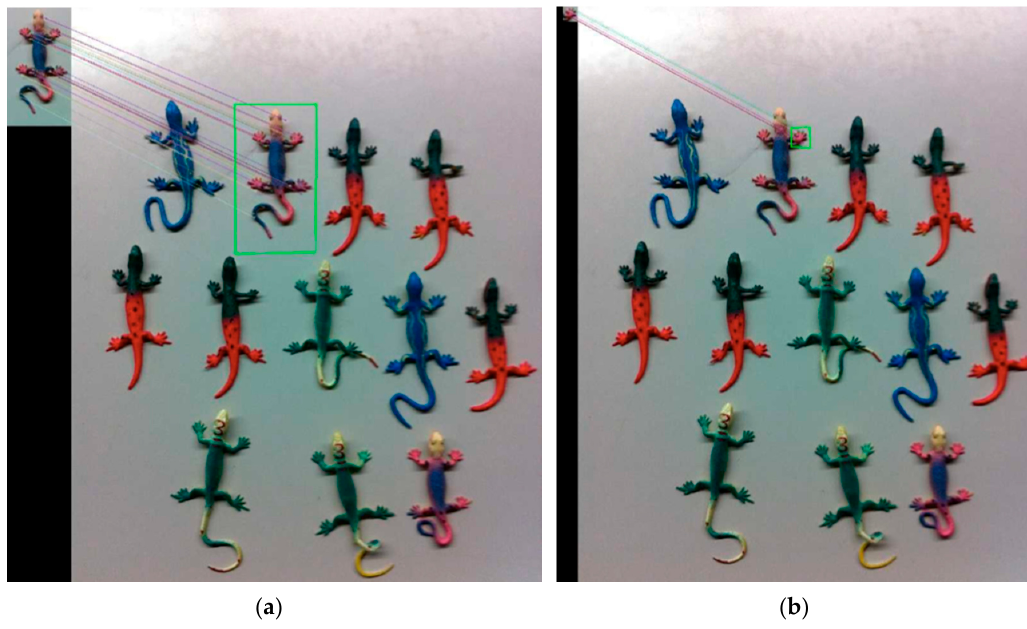
Figure 16. Template search using the SIFT algorithm: ( a ) Full body template of a specimen; ( b ) Right front claw of the specimen.